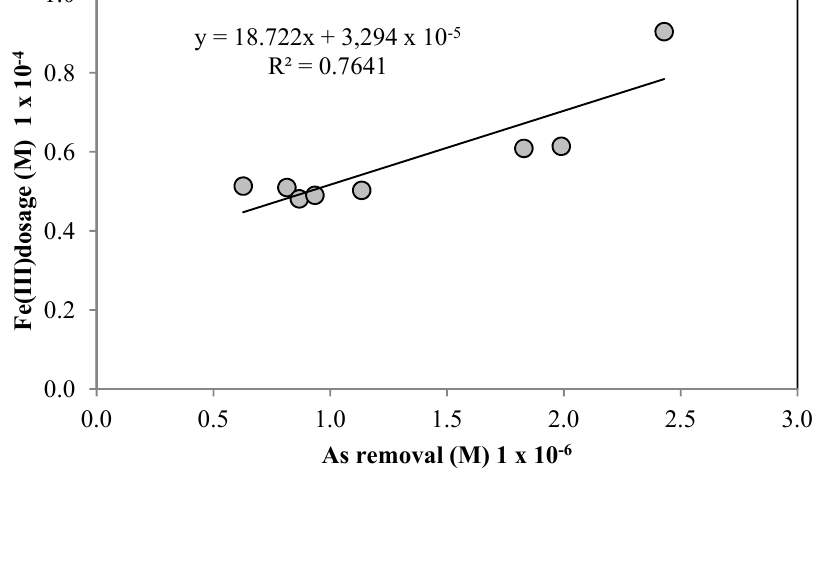
y = 18.722x + 3,294 x 10 -5 R² =